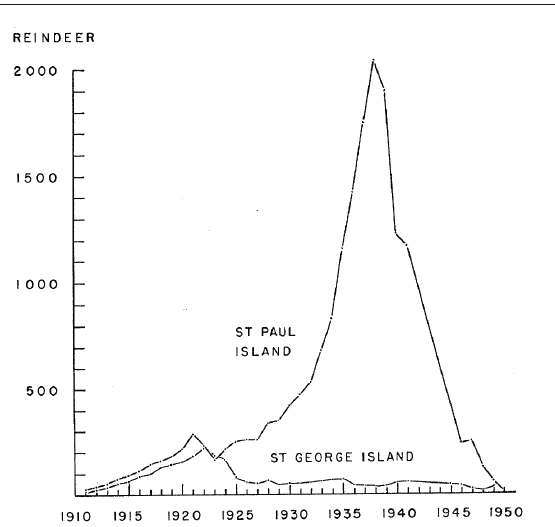
Figure 2: Reindeer population outbreaks and collapse on the Pribilof Islands (Scheffer,